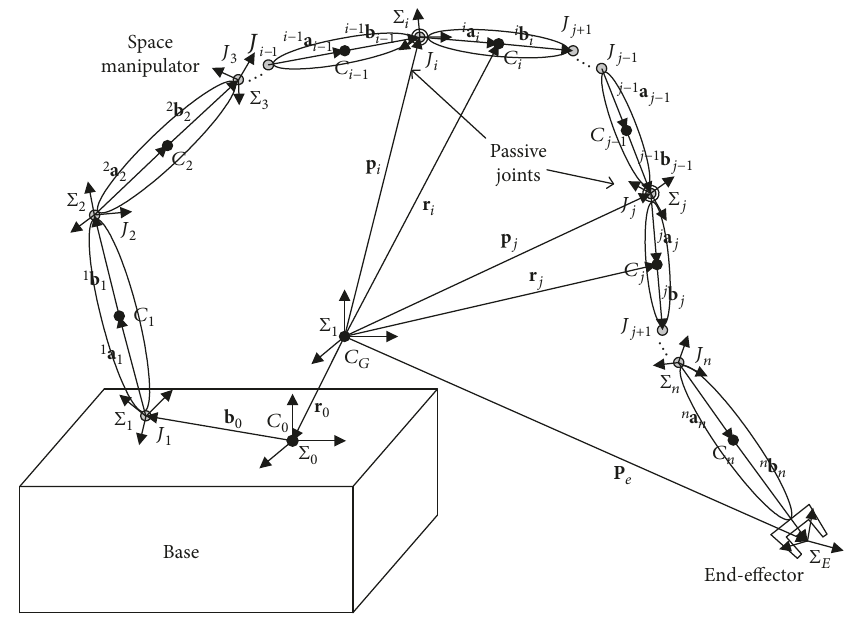
Figure 1: Kinematic model of the n -DOF space manipulator with free-swinging joint